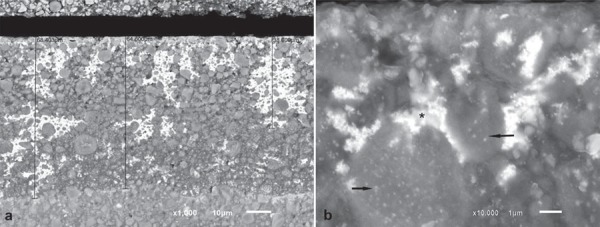
Backscattered electron micrographs of Z-350 resin impregnated with silver. a) Extensive silver penetration over approximately 68.40 µm into the subsurface. The metal is concentrated at specific sites (x1000). b) Another specimen of the same resin group impregnated with silver. The asterisk (*) shows metal surrounding nanoclustered fillers; the arrow shows metal inside nanoclusters (x10000)